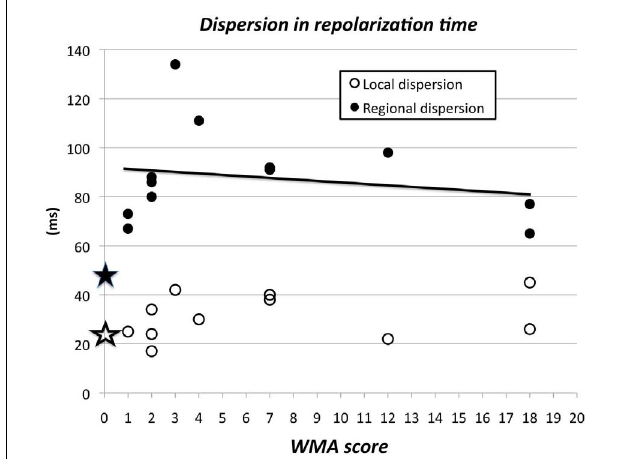
FIGURE 9 |Wall motion abnormality score (index for abnormal wall motion) and regional dispersion in repolarization times. The averaged dispersion in RT of the 11 patients with wall motion score 0 is summarized by the two stars at the ordinate. AtWMA score 1 and local dispersion 25ms there were two patients. A small disturbance of normal wall motion, i.e., hypokinesia in only 1 or 2 out of 12 segments is associated with substantial dispersion in RT. Although the relation betweenWMA score and regional dispersion in repolarization time (restricted to the 12 patients with WMA) was not significant, the regression line Y =− 0.71 × WMA score + 93.0 ( r =− 0.229, n = 12) had an intercept at the Y -axis of 93, substantially more than the regional dispersion of 53 ± 4.1ms in the group with normal wall motion (filled